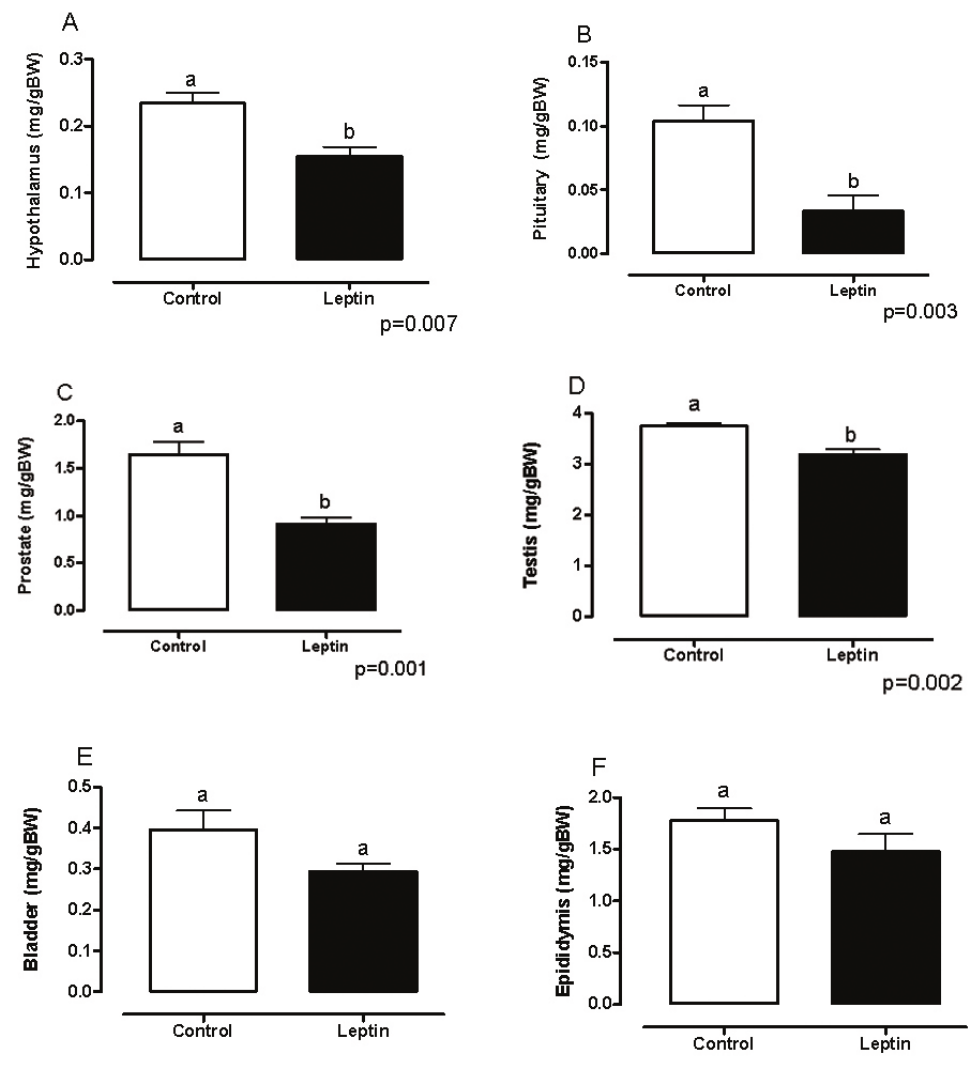
FIGURE 2 - ( A ) hypothalamus, ( B ) pituitary, ( C ) prostate, ( D ) testis, ( E ) bladder and (F) epididymis weights in control and leptin treated groups. Values are given as mean ±SEM of 6